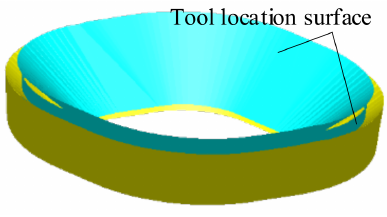
Figure 8. The second stage forming